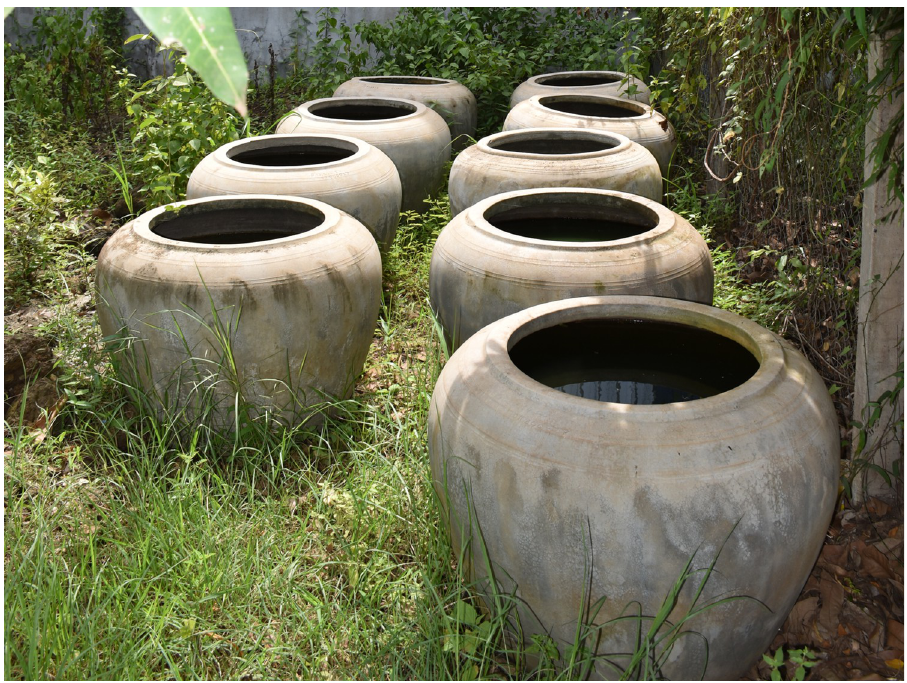
Fig 1. Example of a guppy fish farm established in large concrete water jars in a community health centre.